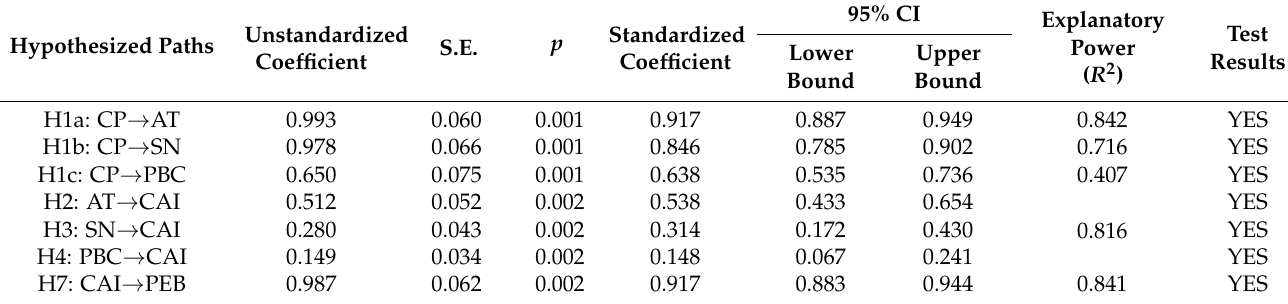
Table 4. Results of the path analysis and hypothesis testing.